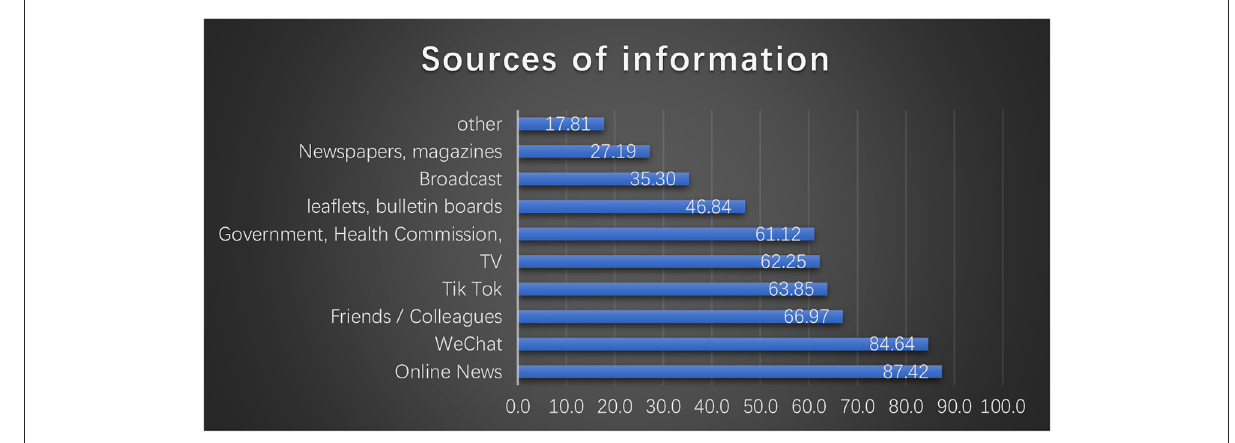
FIGURE1 Source of COVID-19 information reported by